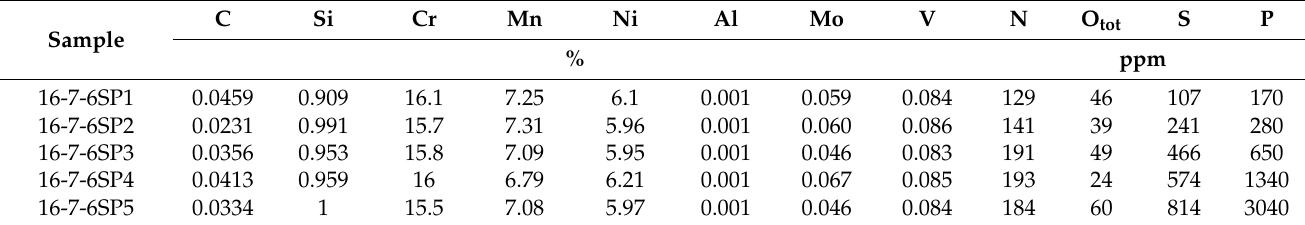
Table 1. Chemical composition of the atomized samples, mass %.